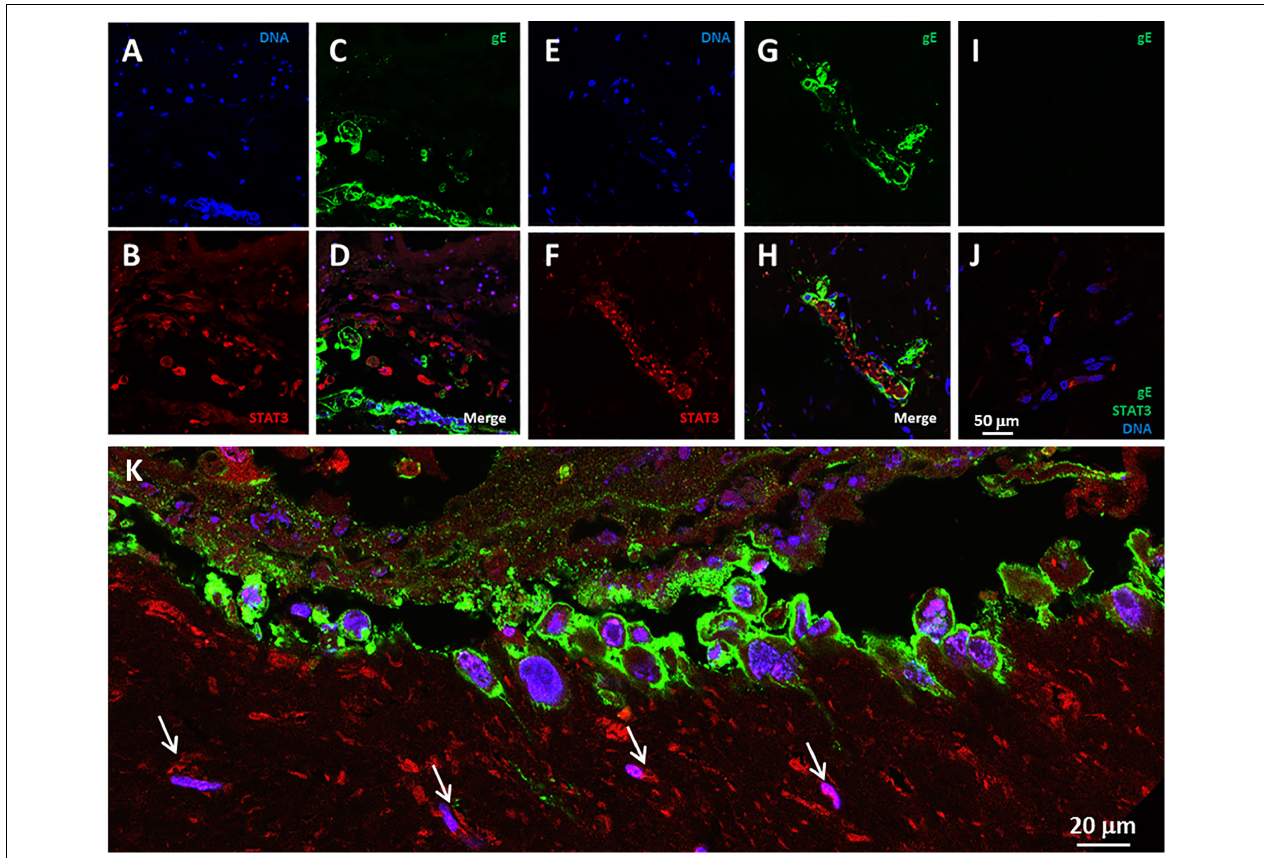
FIGURE 3 | STAT3 expression in VZV infected human skin explants. (A–H) STAT3 expression at 14 dpi (A–D) and 28 dpi (E–H) . The panels show infectious foci outlined by VZV gE immunolabeling mainly in the outer cell membranes, with STAT3 positive cells in the vicinity of the infected cells. (A,E) Blue, Hoechst 33342. (B,F) Red, STAT3. (C,G) VZV gE, green. Panels D,H are the merged images of infected explants. (I,J) Control images of mock-infected skin explants. The white bar in panel J represents all prior panels. (K) A higher magnification landscape image of an infectious focus at 14 dpi with a merge of all colors. Arrows designate cells with immunolabeling for